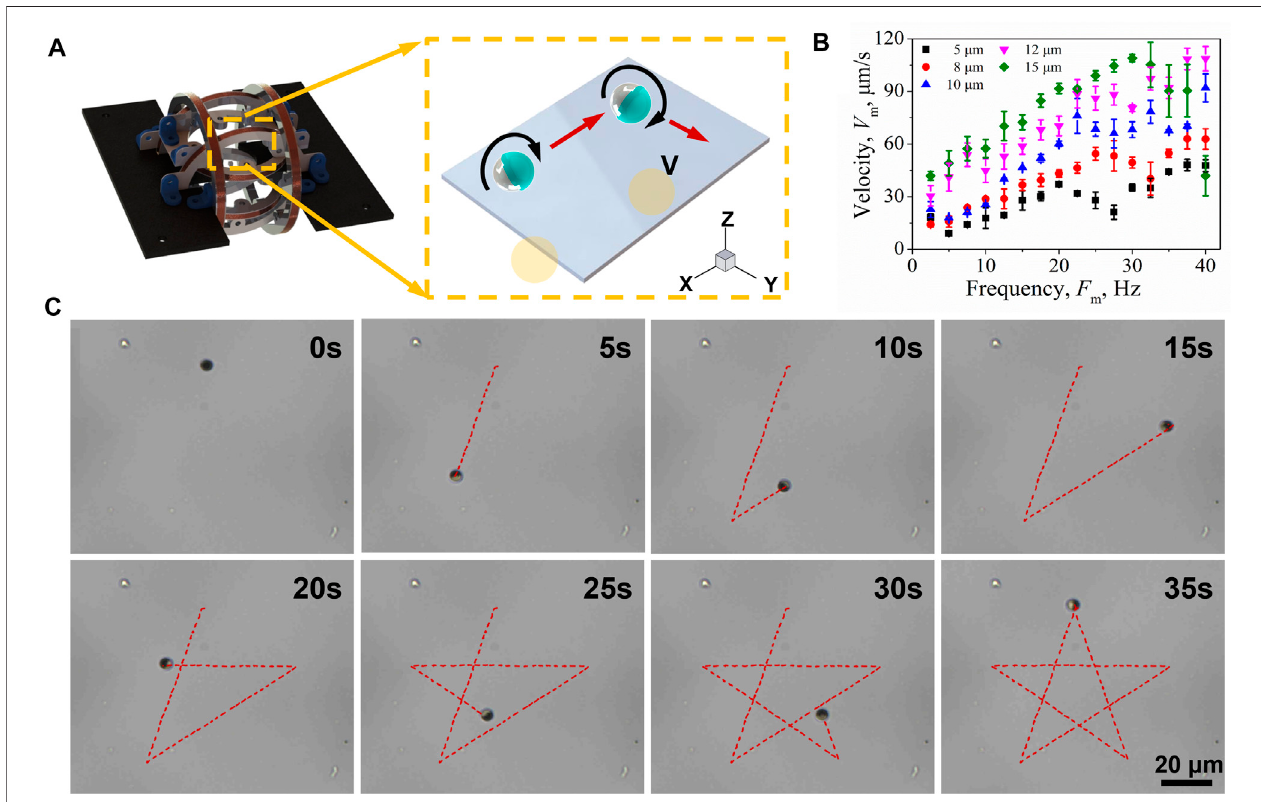
FIGURE4| PropellingandsteeringofJanusmicrorobots. (A) Schematicoftheuniformrotatingmagnetic fi eldgenerationsystem. (B) SpeedofJanusmicrorobots with different diameters of 5, 8, 10, 12, and 15 μ m upon varying the magnetic frequency from 0 to 40 Hz. (C) Janus microrobots are steered along speci fi c paths that form the “ star ”